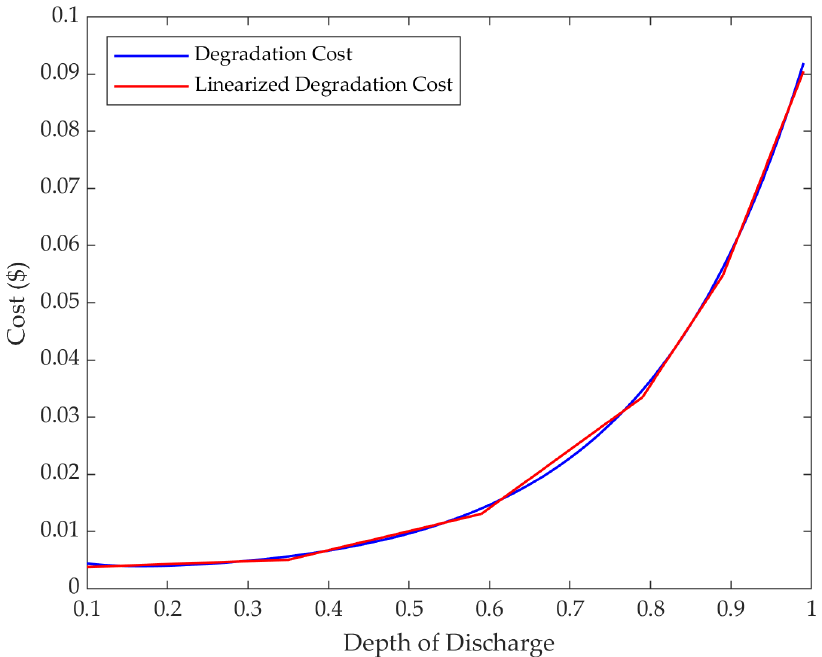
Figure 3. Battery degradation